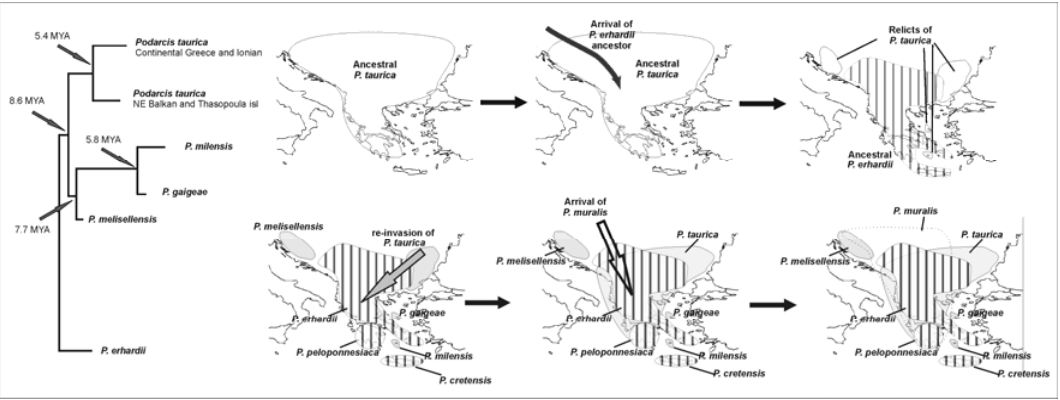
Figure 5. Phylogenetic relationships of P. taurica group and the proposed interaction with the P. erhardii group after [17]. Taxa respect the 12-9 MYA boundaries and contemporary species, such as P. erhardii , differentiate near the Messinian crisis. Dotted line depicts proposed dispersal route. Grey arrow suggests a second invasion from the